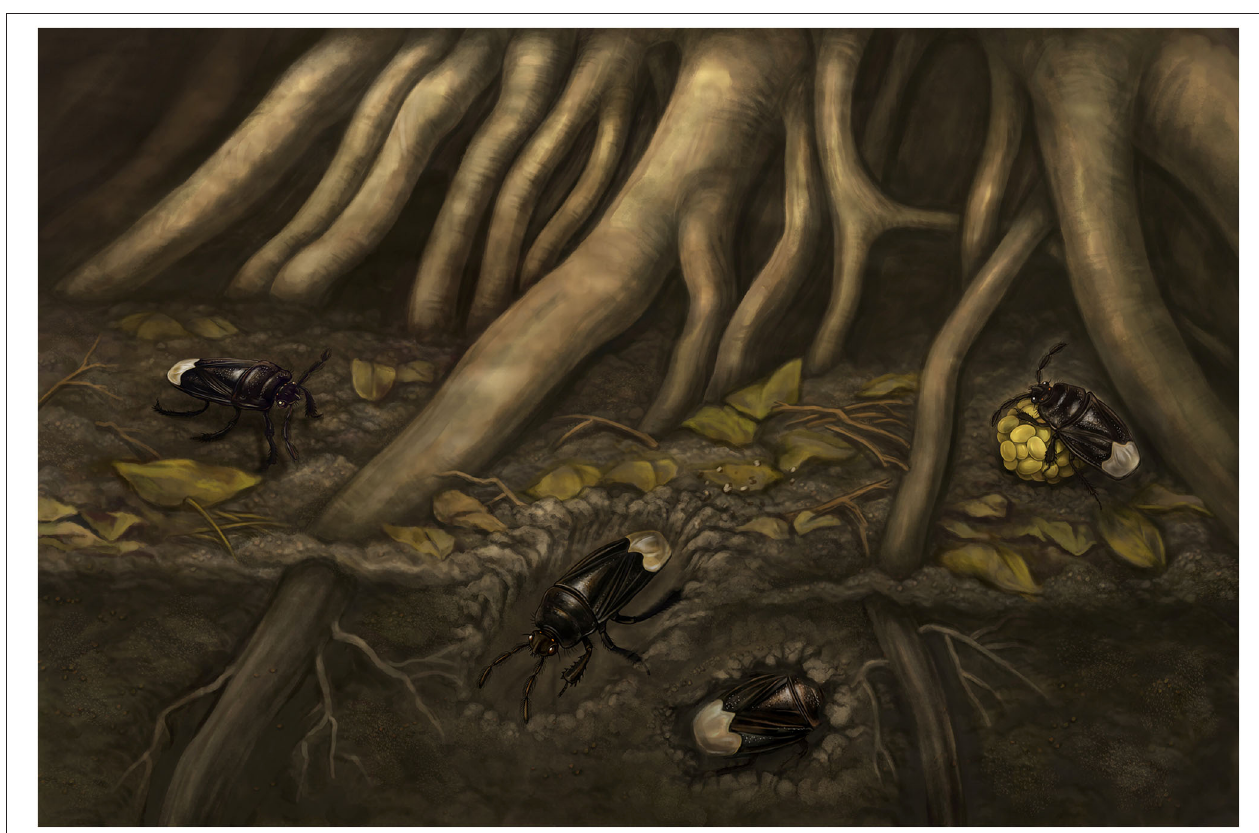
FIGURE 13 | Three-dimensional ecological reconstruction of Acanthamnestus atridorsus gen. et sp.